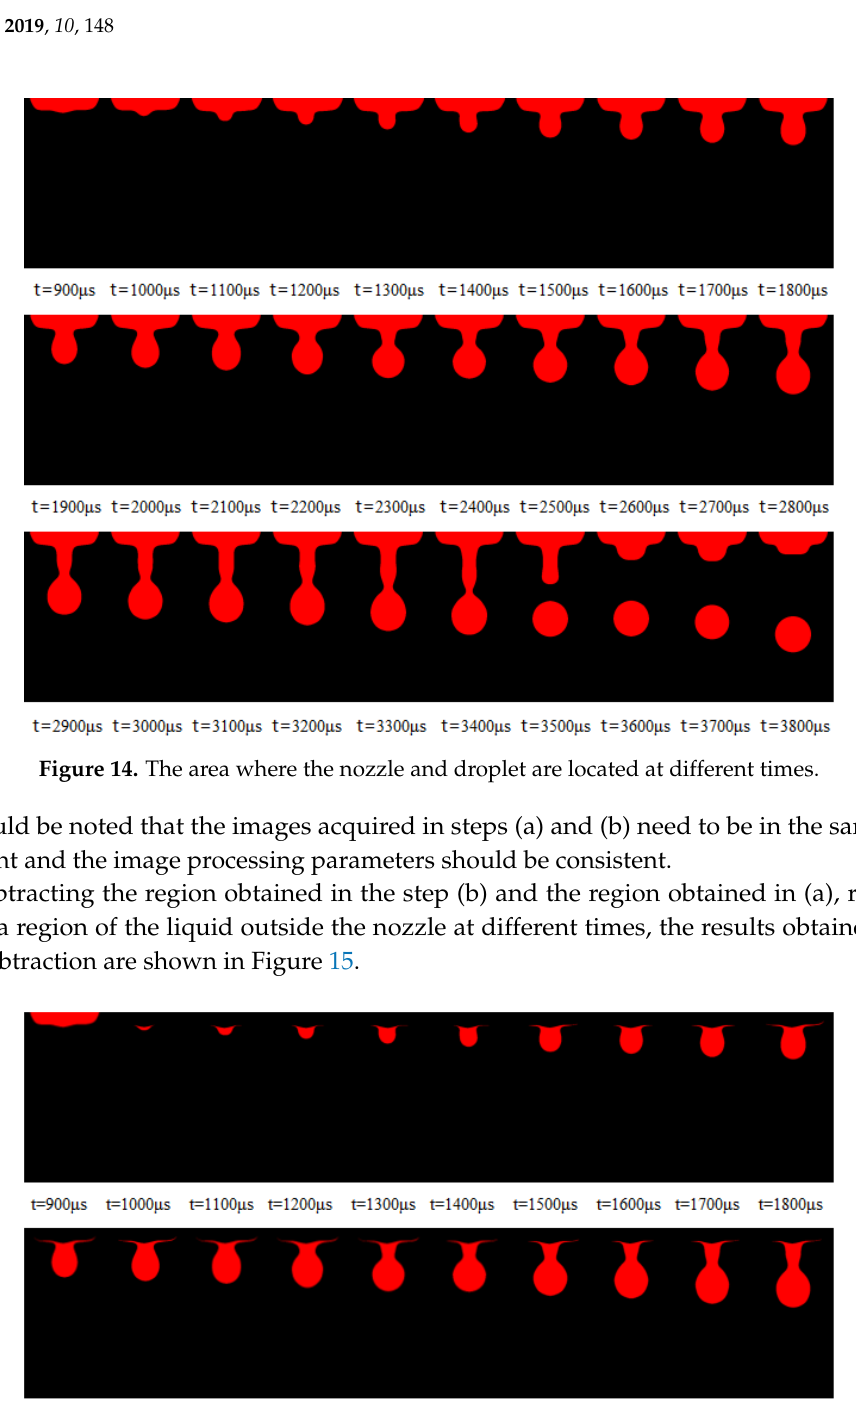
Figure 13. The area where the nozzle is located when there is no injection.